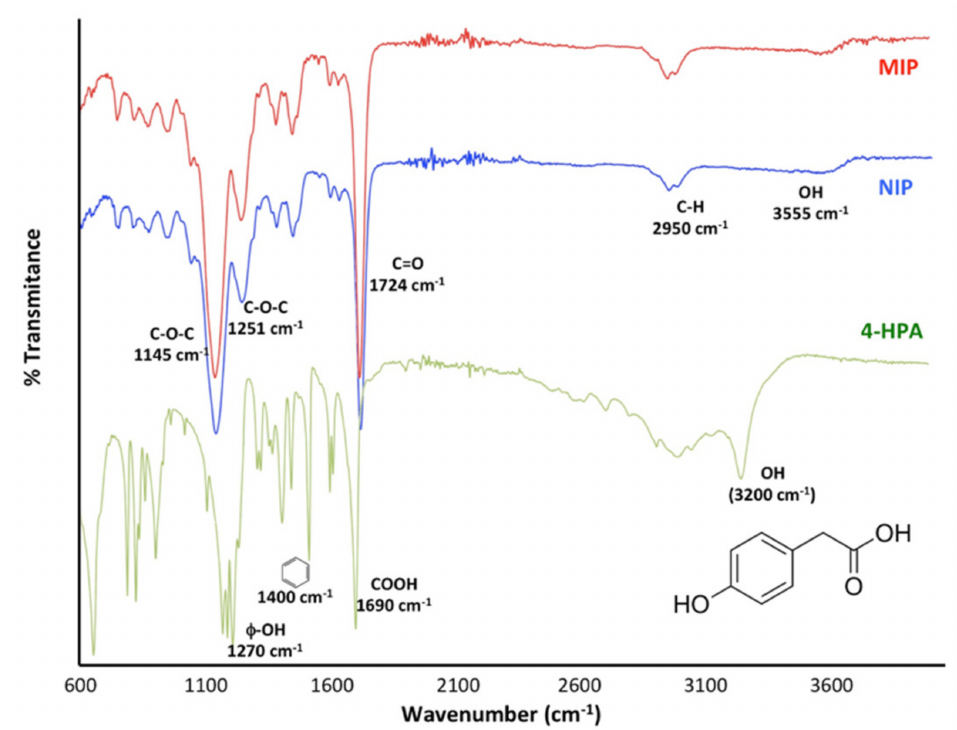
Figure 4. ATR-FTIR spectra for MIP, NIP, and